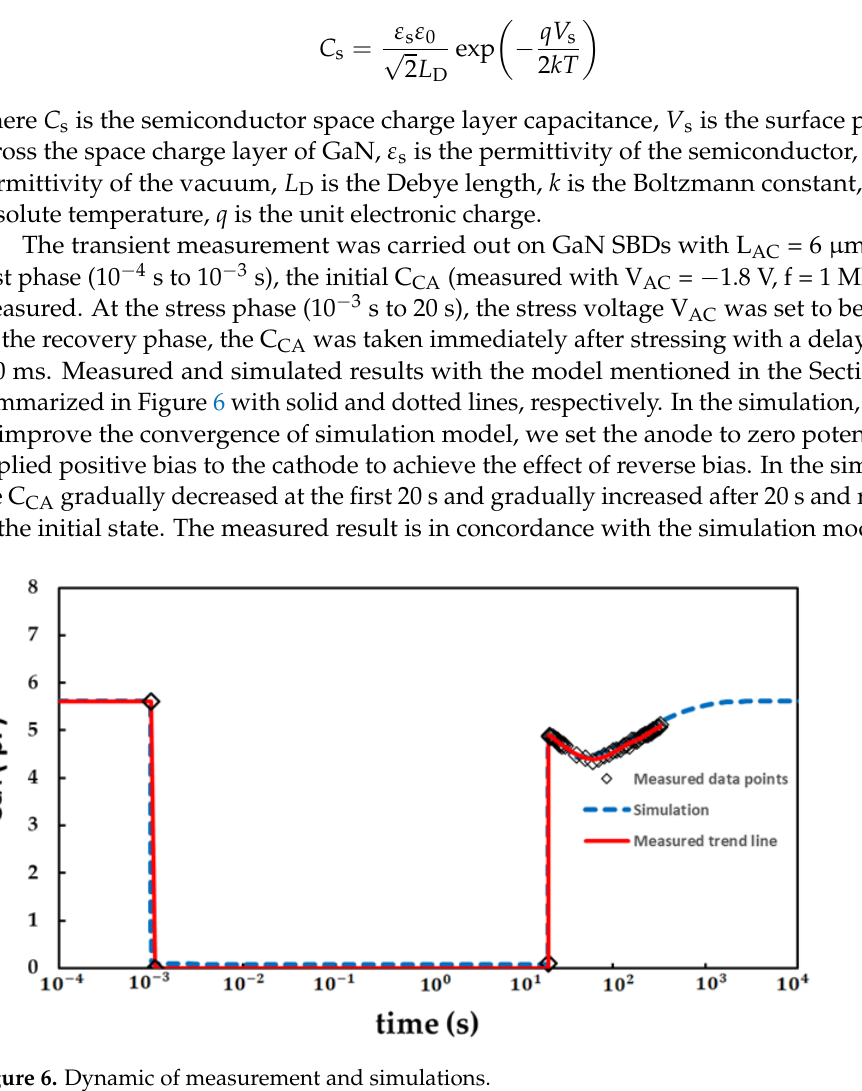
Figure 6. Dynamic of measurement and simulations.